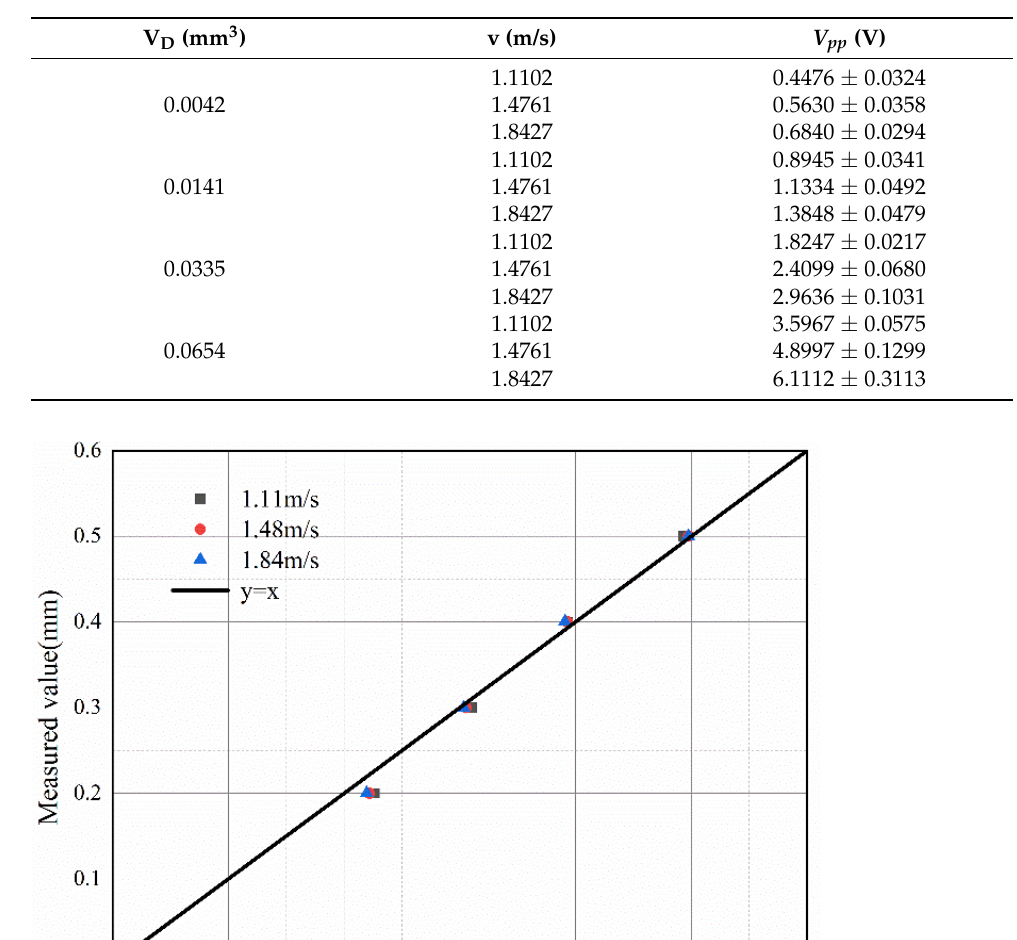
( b ) Figure 17. Lube oil experiment: ( a ) wear debris monitoring test bench; ( b ) results obtained from the oil experiment. 7. Conclusions In this paper, a permanent magnet axisymmetric high-gradient magnetic field wear debris sensor is proposed. Compared with other types of electromagnetic sensors, this sensor has a smaller size, is prone to less interference, and has a higher detection accuracy for ferromagnetic wear particles. A mathematical model of the sensor is proposed, and the influence of various parameters on the sensing performance is analyzed by software simulation. The correctness and rationality of the model and simulation results were ver- ified in a single wear debris experiment. The optimal air gap was selected, and it was